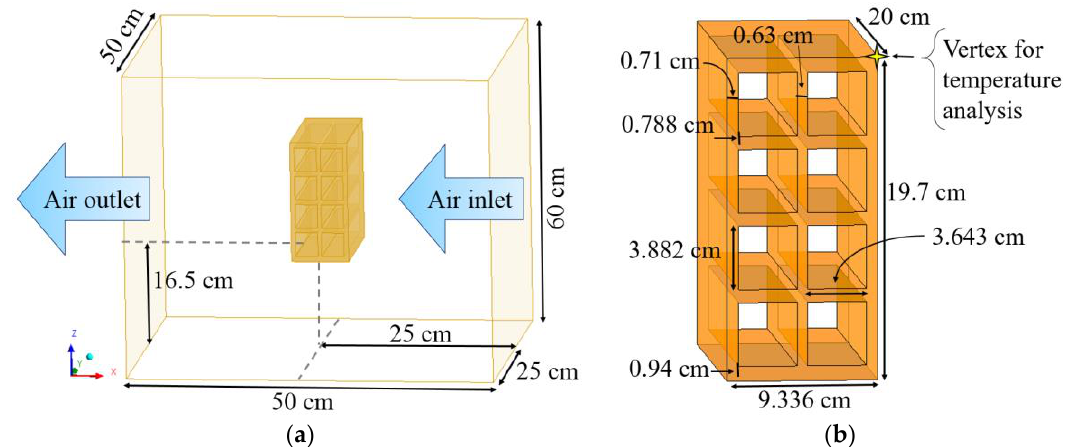
Figure 2. Geometry representative of the ( a ) oven with ceramic brick and ( b ) brick.